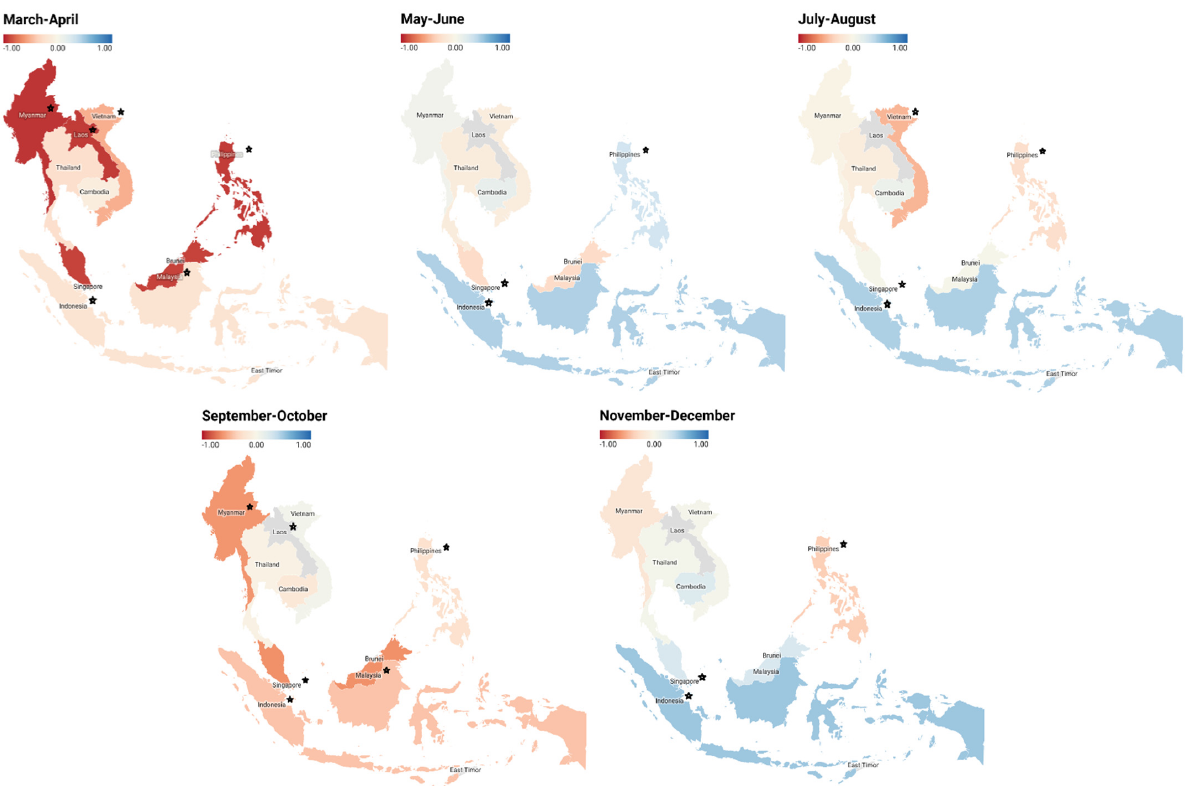
Figure 4. Path coefficients of community mobility to COVID-19 cases in each country from the bi- monthly analysis. A star indicates a significant coefficient ( p < 0.05). A negative value suggests that the community mobility could suppress COVID-19 cases.